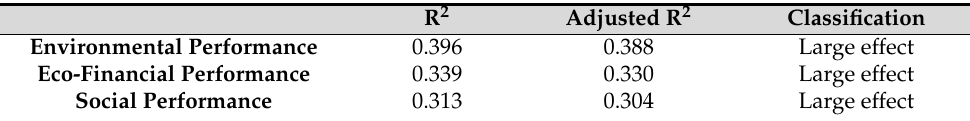
Table 10. Pearson’s coefficients of determination (R 2